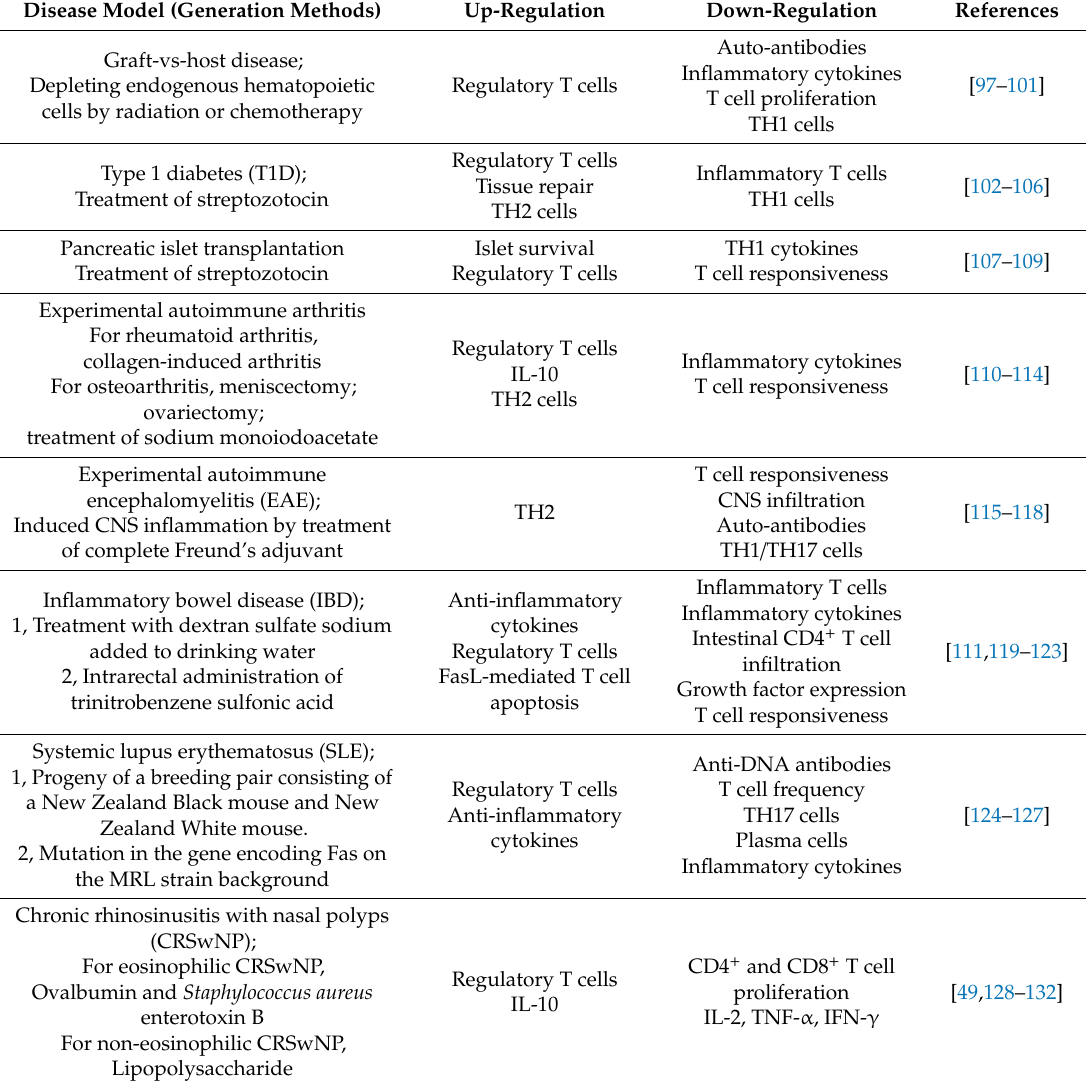
Table 2. E ff ect of mesenchymal stem cells in inflammatory-related disease animal models. Disease Model (Generation Methods)